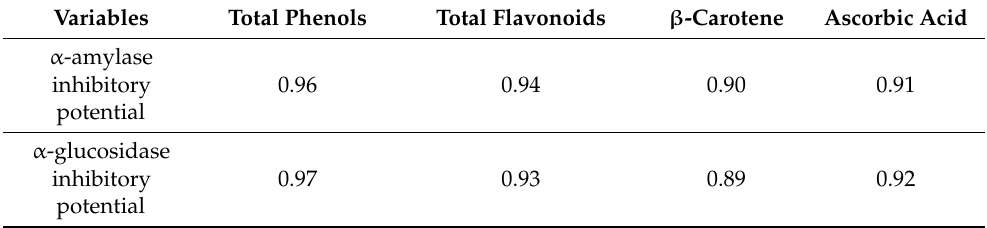
Table 4. Correlation matrix between different variables and bioactive constituents (fresh T. officinale leaves).